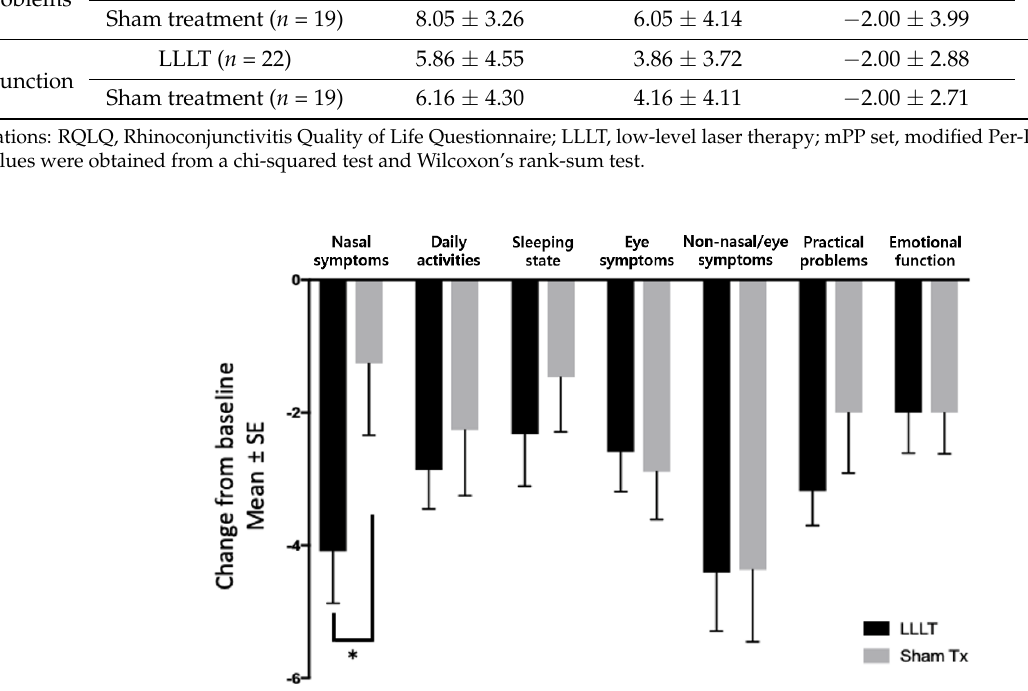
Figure 4. Seven domains of the RQLQ change from baseline. * p < Table 6. Treatment effects (RQLQ domains, mPP set).